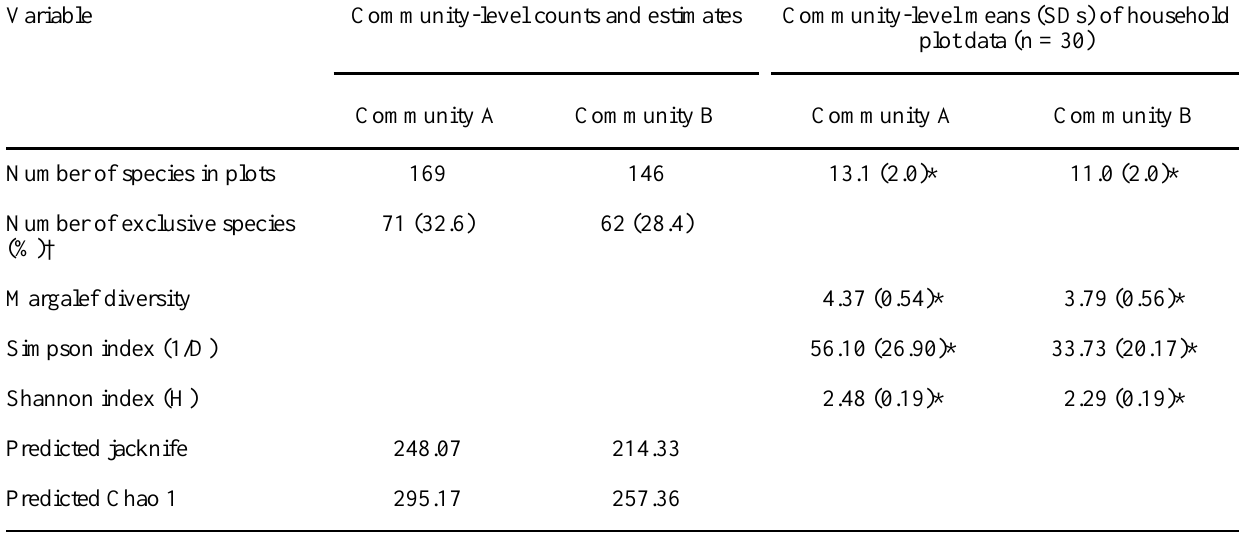
Table 7. Tree species and abundance characteristics in the two